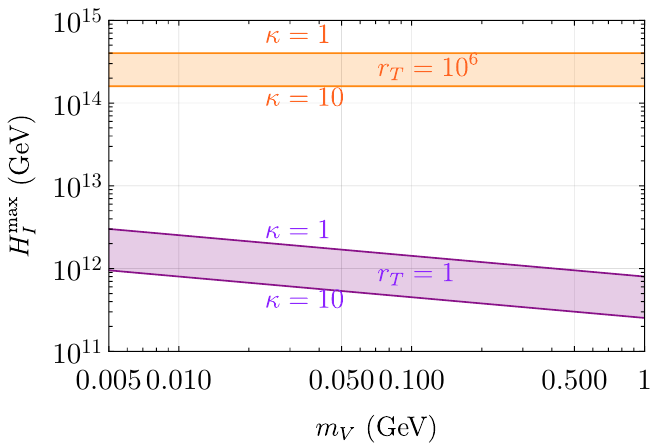
as a function of new vector I = 10 6 ( r = 1 ). In either case, the T T